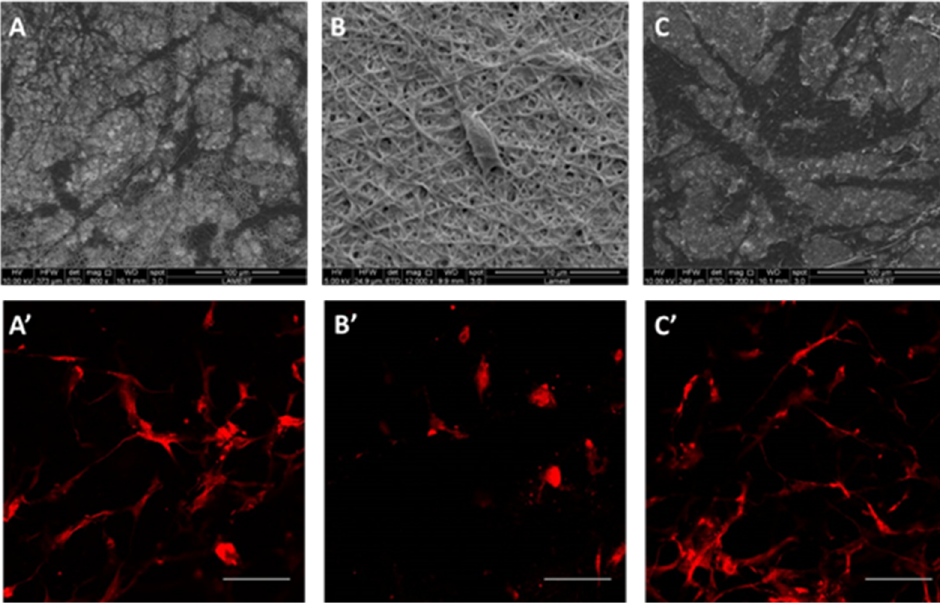
Figure 4. SEM images of hMSCs after 24 h in culture onto bicomponent scaffolds of PCL/gelatin ( A ), PCL/zein ( B ), and PCL/keratin ( C ). Confocal images of hMSCs cultured after 3 days onto bicomponent